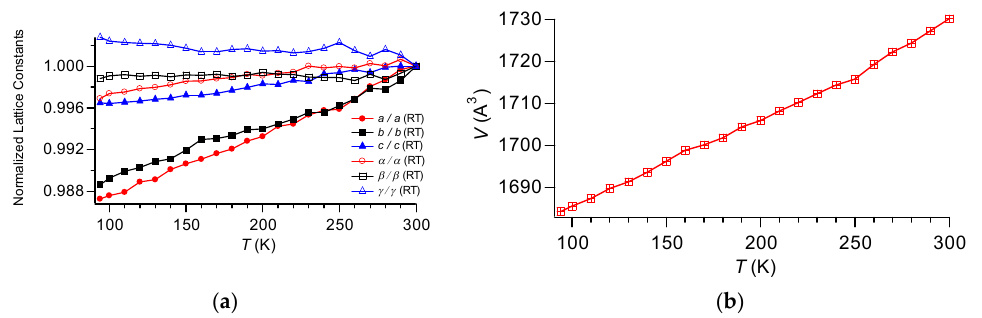
Figure 4. Temperature dependencies of lattice constants of α -STF 2 I 3 (90–300 K): ( a ) Cell parameters ( a / Å, b / Å, c / Å, α / ◦ , β / ◦ and γ / ◦ ) normalized by the respective values at 300 K; ( b ) Cell volumes ( V / Å 3 ).